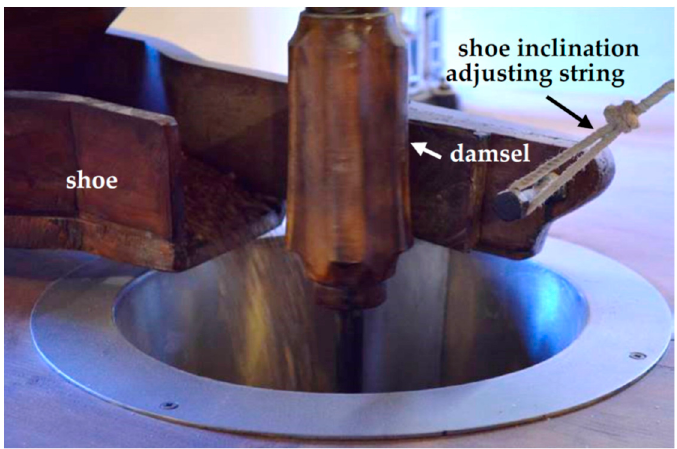
Figure 21. Feeding the millstones.